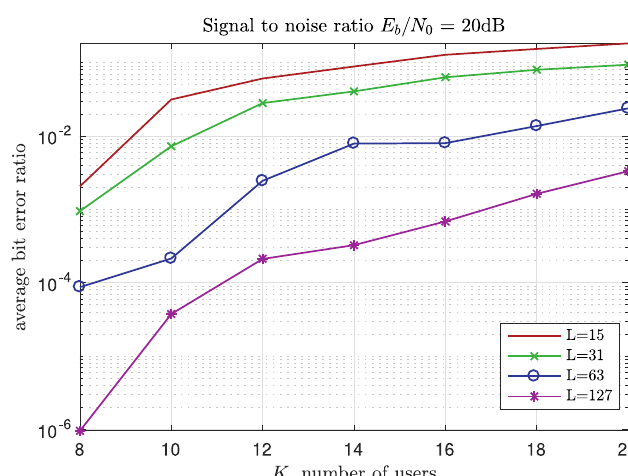
Fig. 5. Asynchronous DS-CDMA: BER dependence on the number of users for 15 to 127 chip-long chaotic sequences generated using logistic, Gauss, cubic maps.